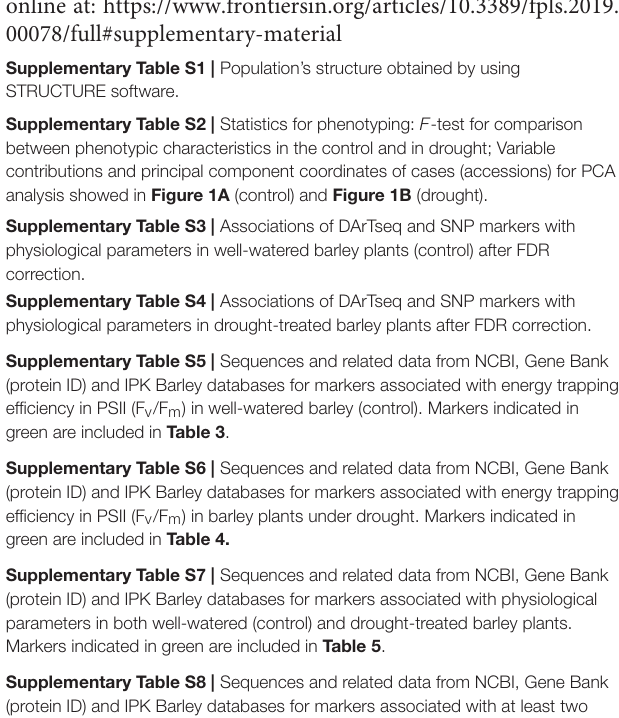
physiological traits in barley plants under drought with exception to the markers associated only with chlorophyll fluorescence parameters. Markers indicated in green are included in Table 6